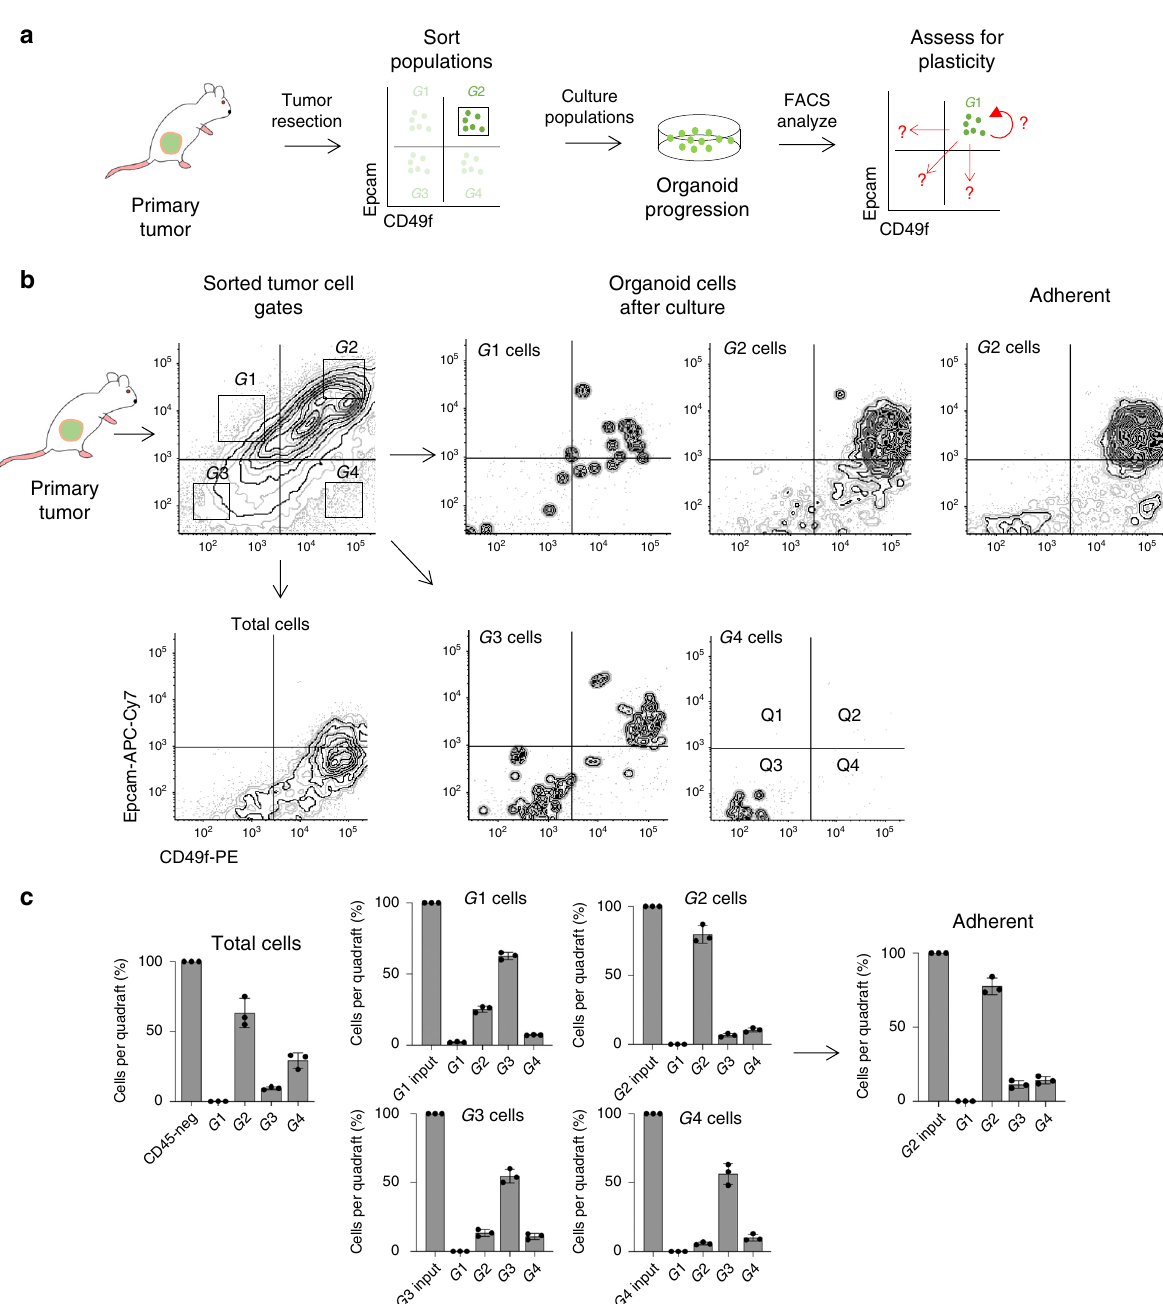
Fig. 6 Lineage plasticity of mouse bladder cancer cell populations in vitro. a Strategy to evaluate the plasticity in Epcam and CD49f expression using sorted populations of OHBBN-induced primary bladder cancer cells cultured as organoids. b Flow cytometry plots showing isolated cell populations of tumor cells (left), grown in vitro for 10 – 15 days, and analyzed for changes in Epcam and CD49f expression. The effects of switching to adherent conditions are shown for gate two (G2) cultured cells (top right) and total CD45-negative cells grown continuously in suspension (bottom left). c Graphs showing redistribution of individual sorted cell populations before (input pro fi le) and after in-vitro culture. Individual data points are represented by circles, the error bars represent mean ± SD of the three independent replicates. Each experiment was performed at least eight